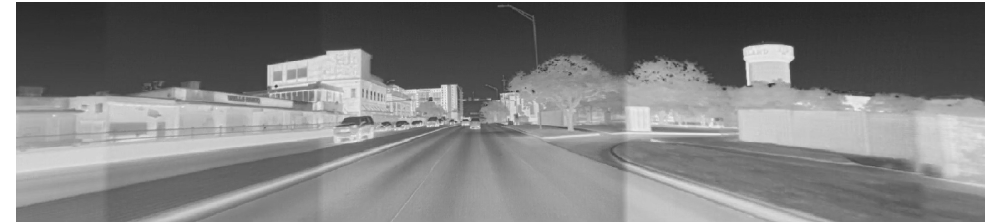
Figure 6. A screenshot of a stitched video feed from the thermal cameras.